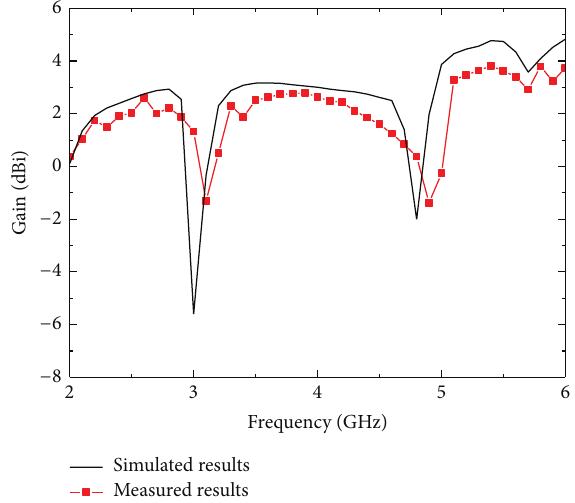
Figure 9: Simulated and measured gains of the proposed antenna in three working bands (unit: dBi).